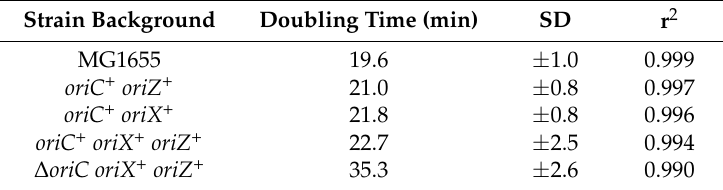
Table 3. Doubling times of E. coli strains with two ectopic replication